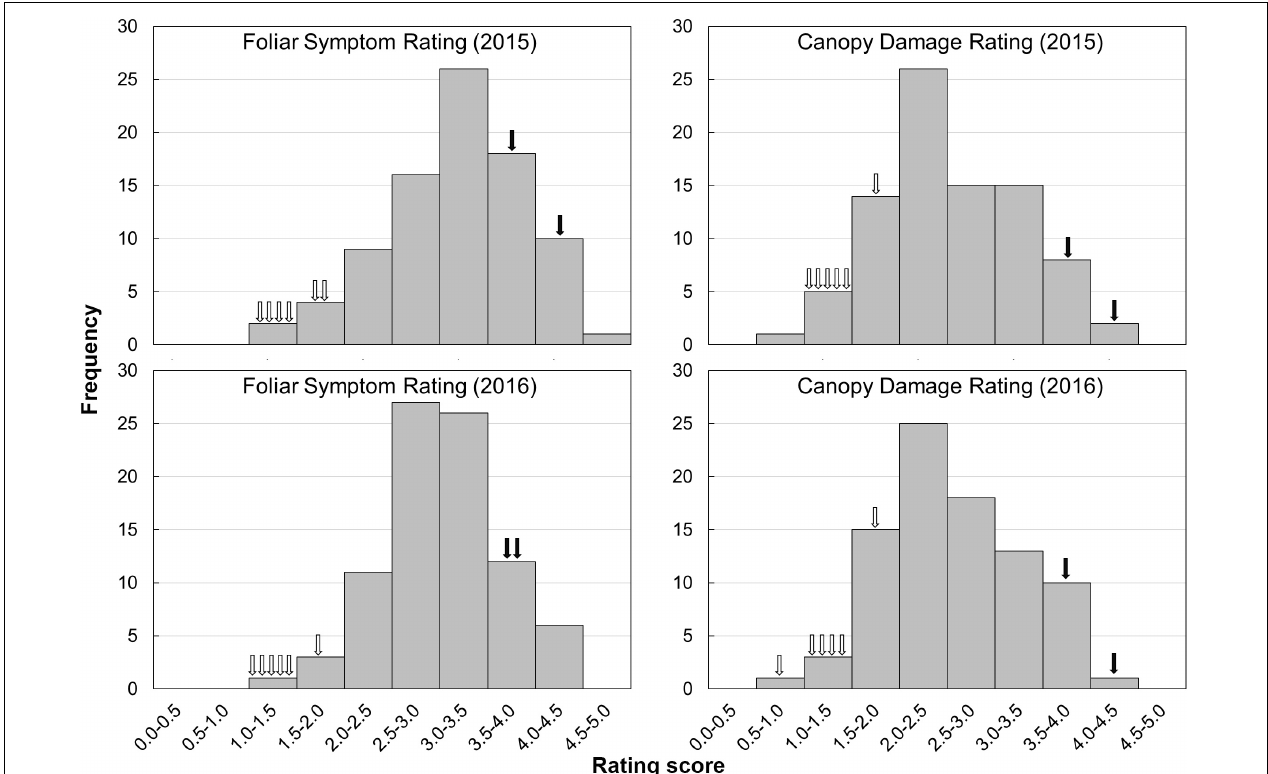
FIGURE 4 | Frequency distributions of foliar symptoms rating and canopy damage rating in F 1 progenies and parental varieties in 2 years. The hollow arrows indicate each of the trifoliate orange varieties, while the solid arrows indicate each of the sweet orange